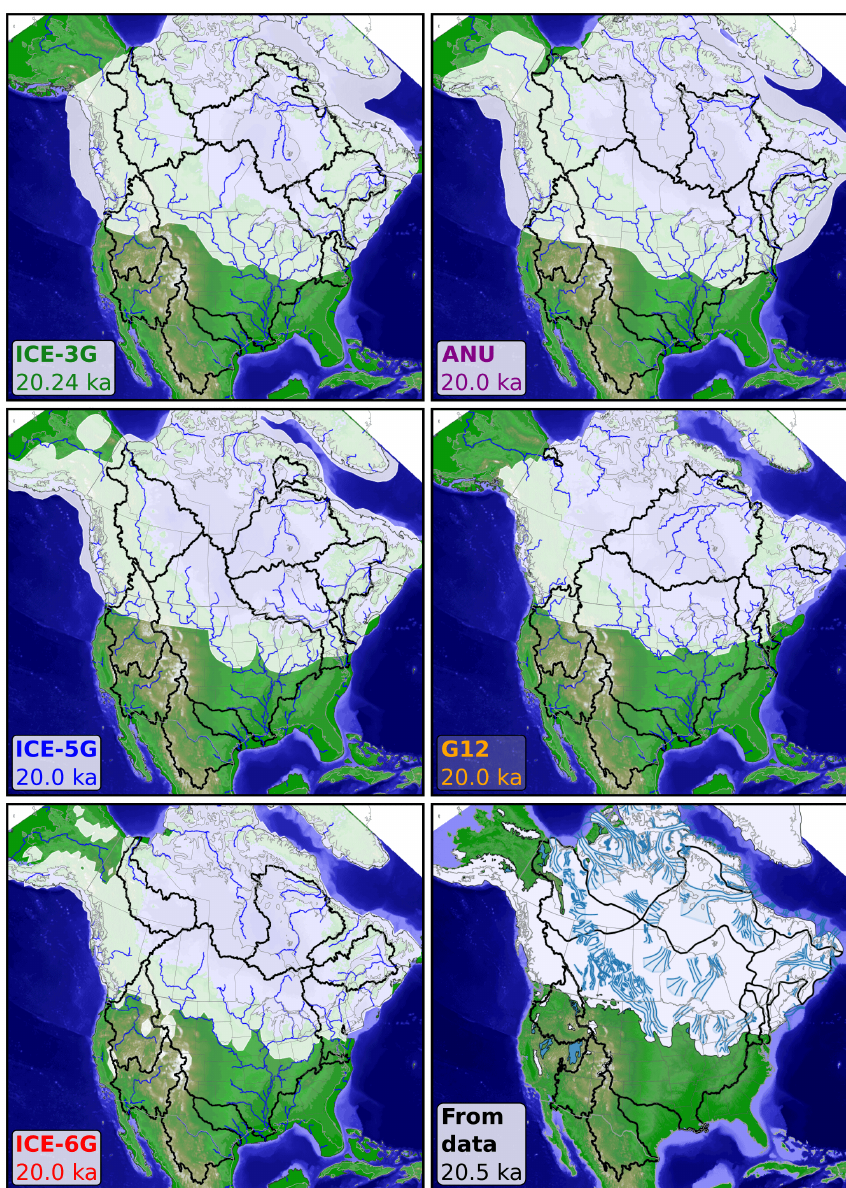
Figure 7. End of the global LGM. North American drainage basins at the LGM. Ice models are organized left to right, top to bottom, in the order of their publication age. Drainage basins are delimited in black. Blue lines on the model output panels trace corridors through which total water discharge (ice melt and meteoric) is ≥ 1000m 3 s − 1 ; these lines are based on raw outputs that are not adjusted based on modern or preindustrial discharge (Sect. 2.5, last paragraph). The data-driven compilation indicates evidence of past ice streams in blue (Margold et al., 2014). The model- and data-driven reconstructions show a generally consistent trend of an enlarged Mississippi River drainage basin, ice flow via Hudson Strait into the North Atlantic, and ice-sheet meltwater routed down the Hudson and/or Susquehanna